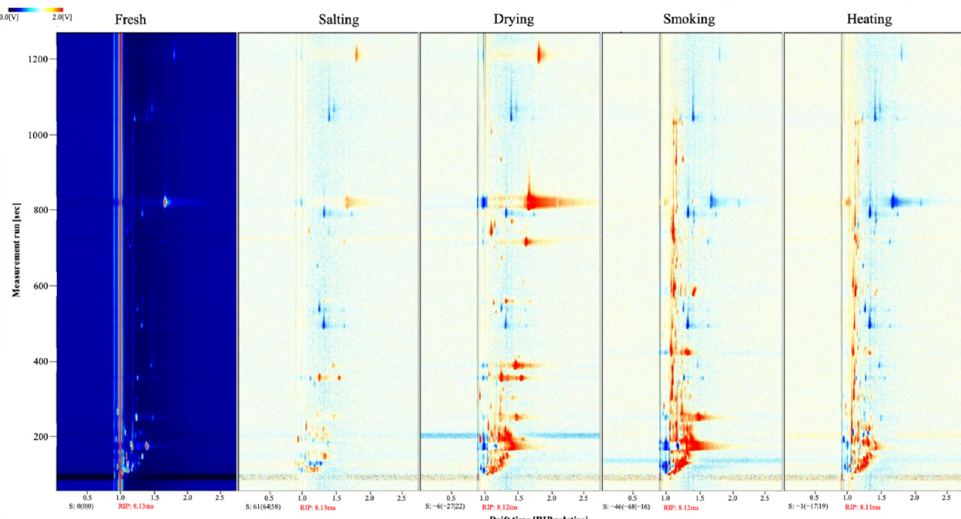
Figure 4. Two-dimensional (2D)-topographic subtraction plots based on the signal intensity of smoke-flavored sea bass with different production steps via HS-GC-IMS. The horizontal axis represents the ion migration time (ms), and the vertical axis represents the retention time (s).